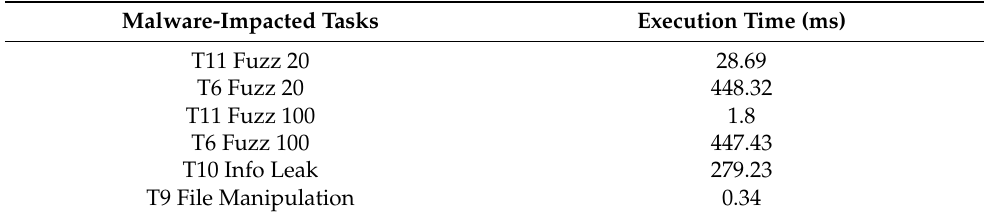
Table 4. Execution times of compromised insulin pump